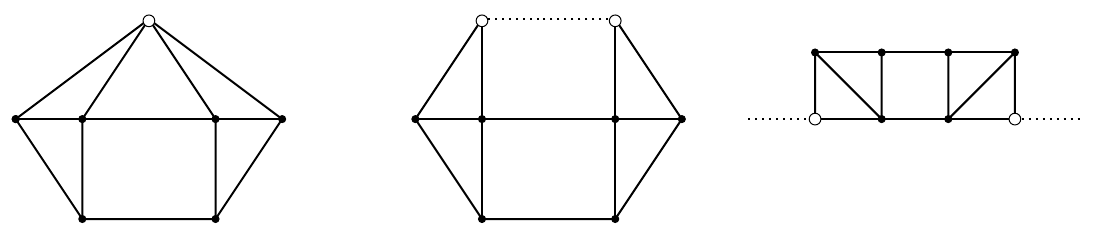
Figure 3 . We split the quartic vertex into a pair of cubic vertices connected by a new propagator (dashed). Cutting this propagator yields yet another finite